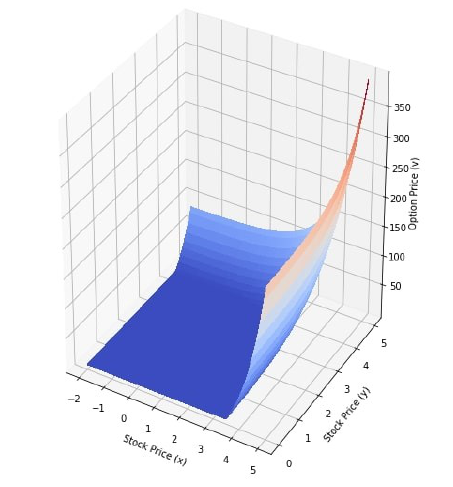
Figure 4. Values of the options for α = 1 and ρ = 1.15.